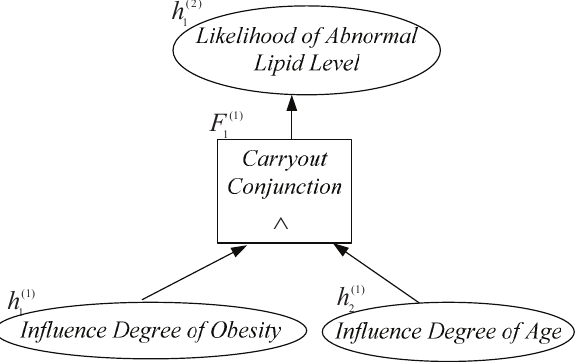
Figure 4. GBINM guides in linking the output of branches.